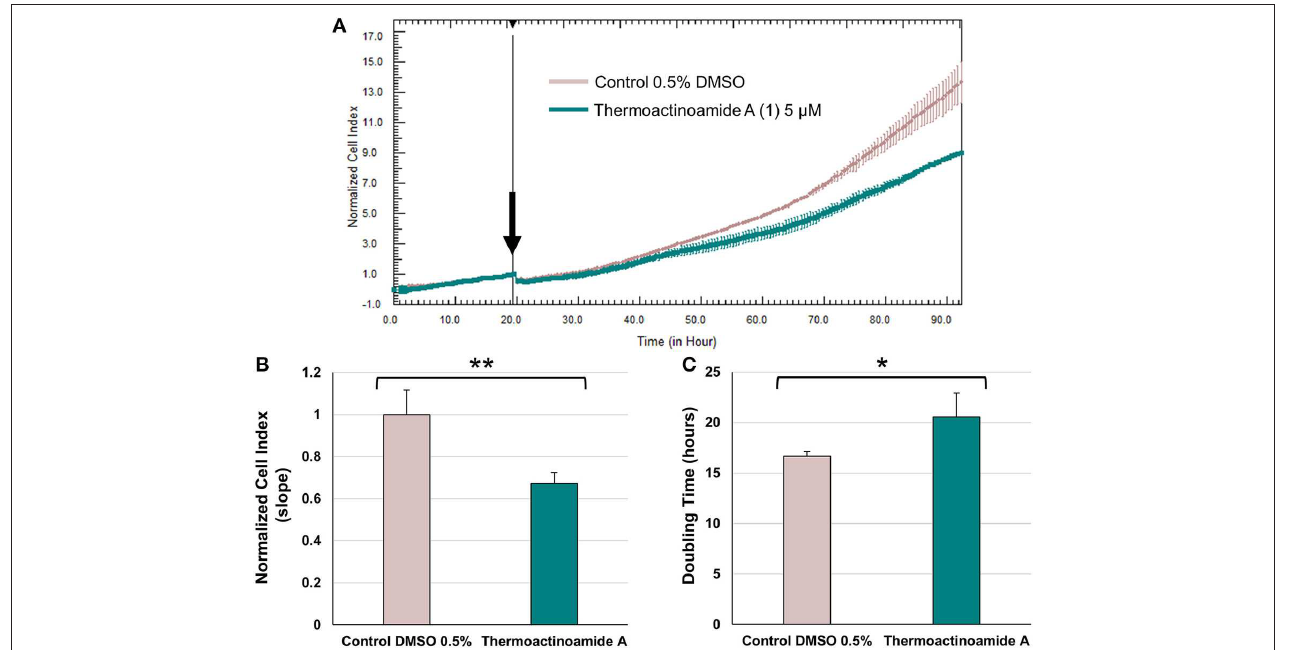
FIGURE 6 | Effects of thermoactinoamide A ( 1 ) on the proliferation of BxPC-3 cells monitored in real time using the RTCA platform. (A) Normalized cell index (NCI) kinetics of the BxPC-3 cells exposed to 0.5% DMSO vehicle and 5 µ M of thermoactinoamide A. Arrow shows the starting point of treatment of the cells. Each cell index value was normalized to this starting point. (B) Decrease of the slope of BxPC-3 proliferation curve describes the rate of change of NCI after 72h drug treatment. Slope values of NCI curves are relative to controls treated with 0.5 % DMSO vehicle. (C) Doubling times of NCI of BxPC-3 cancer cells after 72h treatment with 5 µ M of thermoactinoamide A and 0.5% DMSO. Doubling time is the time required for a curve cell index value to double. Data are presented as mean ± SD; n = 2. Each experiment was performed in triplicate. * p < 0.05; ** p <